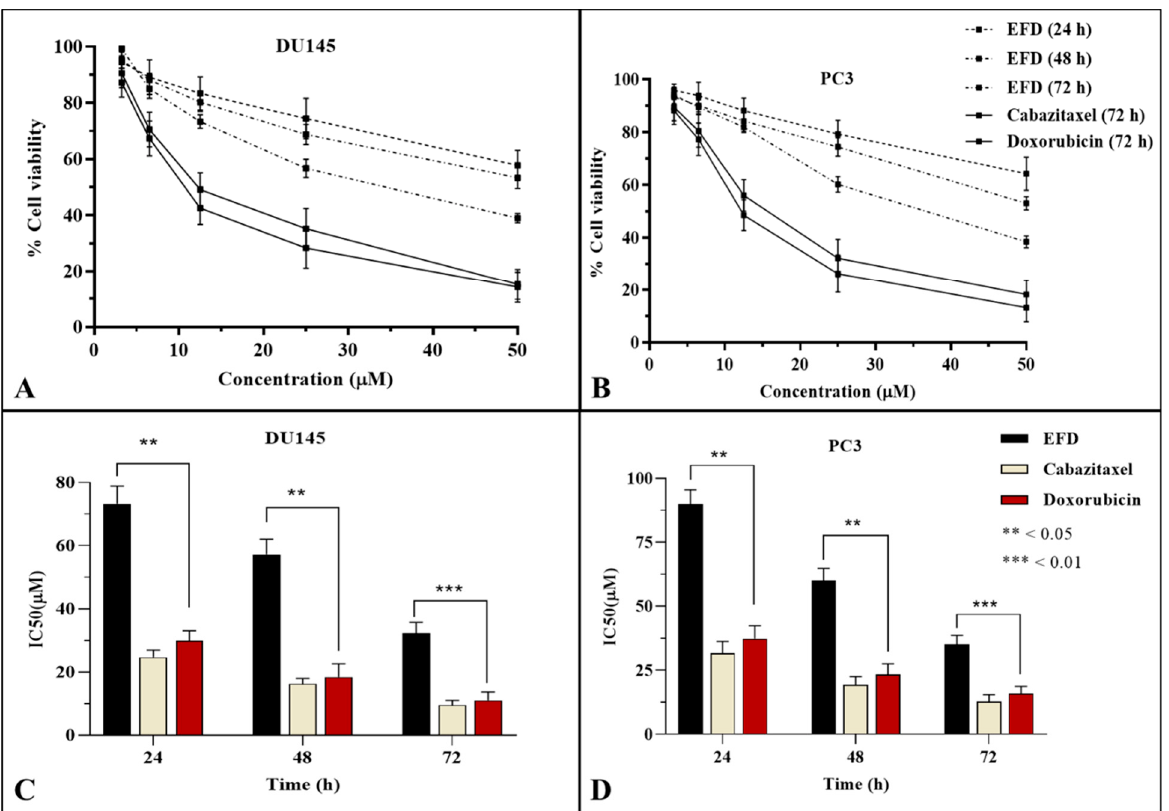
Figure 3. Effect of EFD on viability of prostate cancer cell and IC 50 values. Note: MTT assay was used to determine the viability of cancer cells ( A ) 24, 48 and 72 h treatment of DU145 cells and ( B ) 24, 48 and 72 h treatment of PC3 cells, ( C ) IC 50 values of EFD against DU145 ( D ) IC 50 values of EFD against PC3. Data is mean ± SD of % cell viability ( n = 3) at ** p < 0.05 and *** p < 0.01.